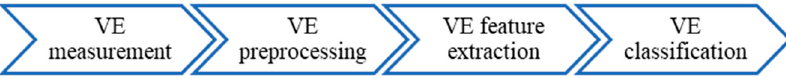
Figure 2. VE data processing steps.